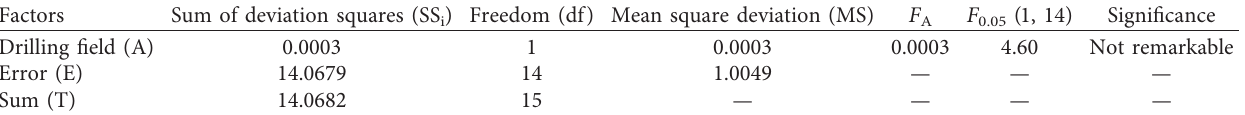
Table 4: Variance analysis of drilling field factor experiment results.